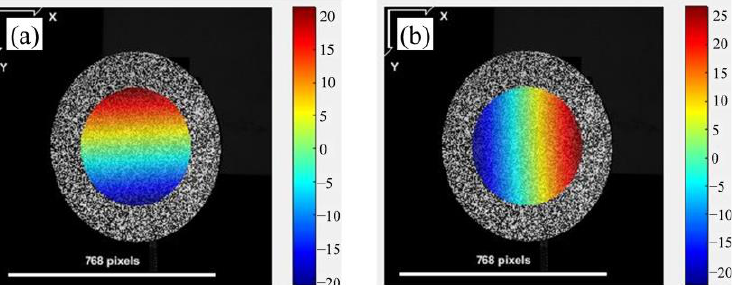
Figure 6. The displacement of integer pixel position. ( a ) Displacement in x direction; ( b ) displacement in y direction.